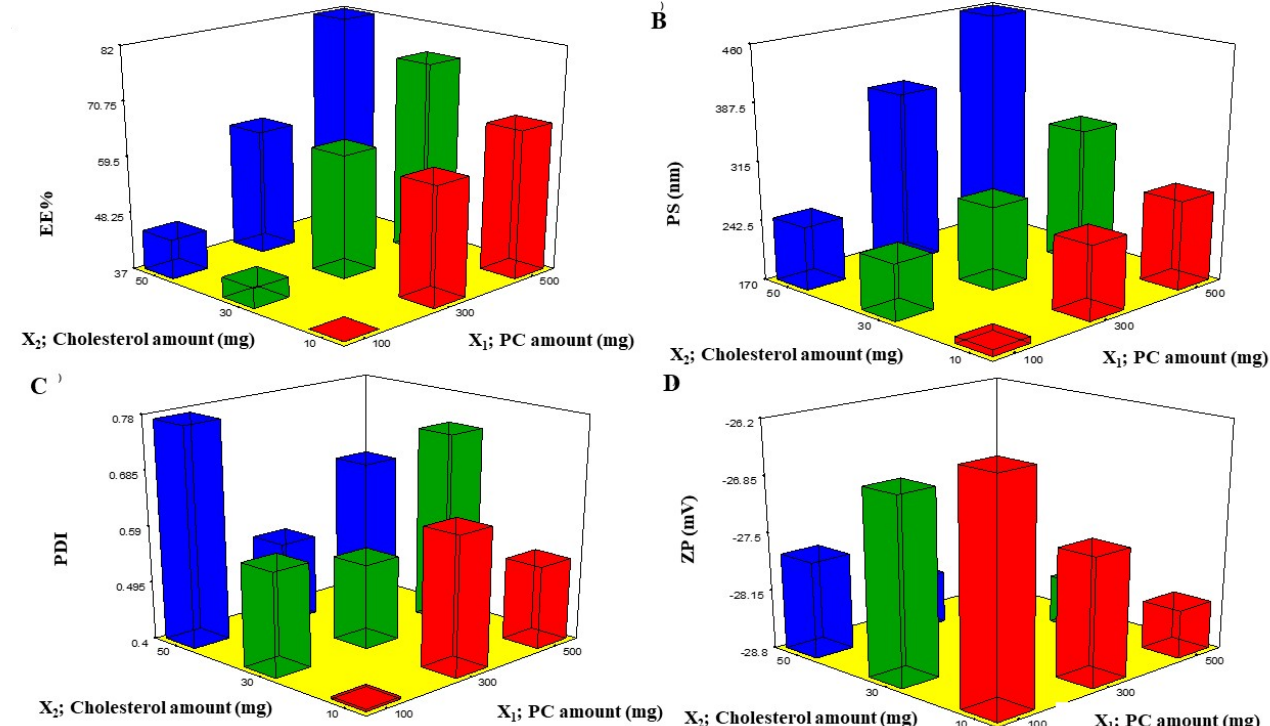
Figure 1. Response 3D plots ( A – D ) for the effect of PC amount (X 1 ) and cholesterol amount (X 2 ) on EE%, PS, PDI, and ZP. Abbreviations: PC: phosphatidylcholine, EE%: entrapment efficiency percent, PS: particle size, PDI: polydispersity index, and ZP: zeta potential.